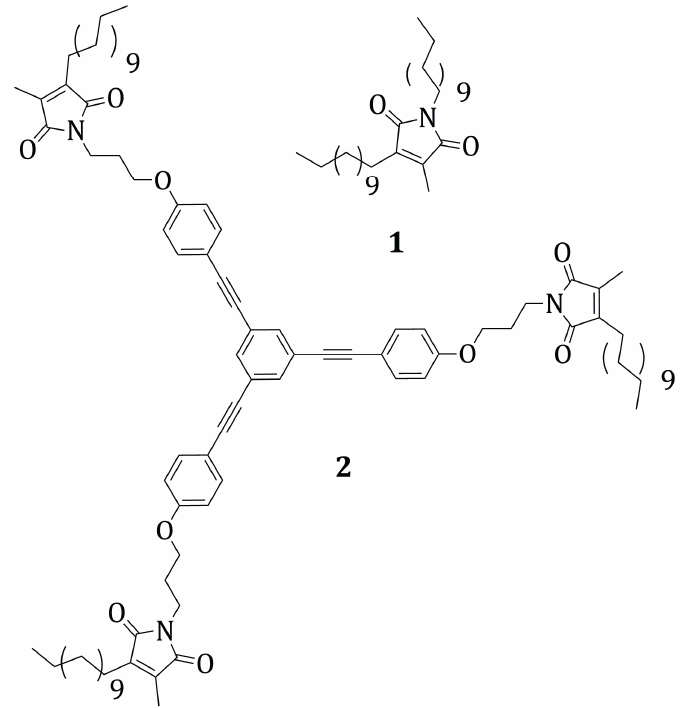
Figure 1. Functionalized maleimides 1 and 2